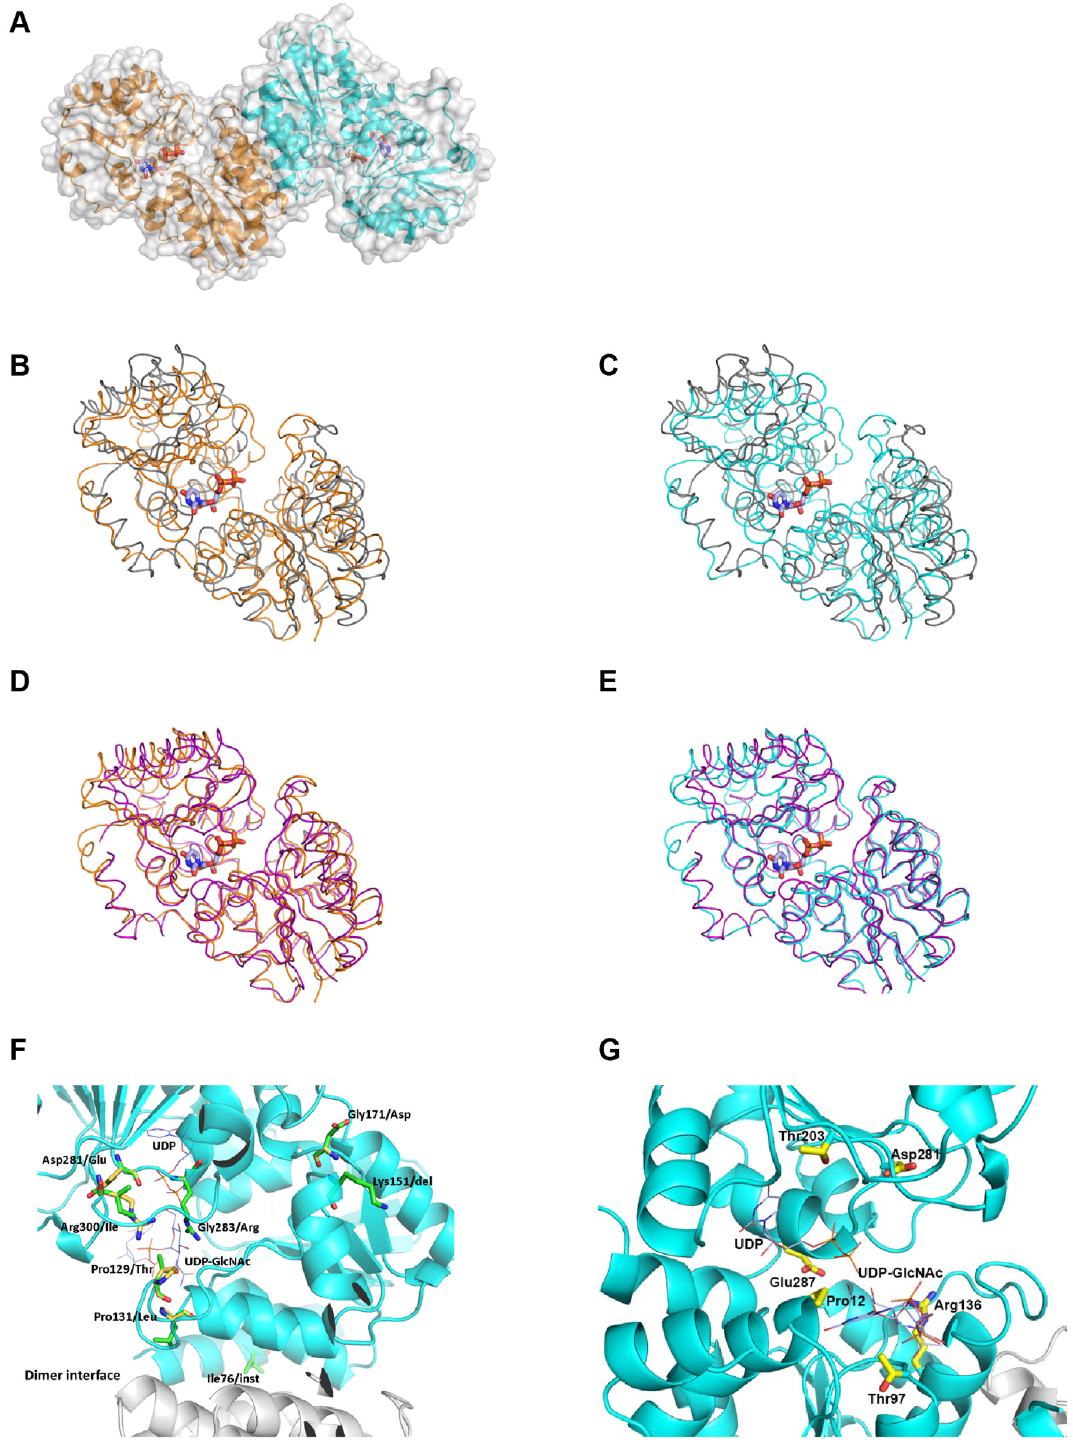
Fig 6. Mapping of MnaA LOF mutations into the MnaA crystal structure reveal key residues for substrate binding site stability and charge. (A) Overall MRSA COL MnaA crystal structure. The molecular surface is shown in grey. The protein is represented as a cartoon. In all figures one monomer is consistently colored in orange and the other in cyan, and the bound UDP molecules are shown as sticks, methyl groups colored in light blue. Nitrogen, oxygen and phosphor atoms are in blue, red or orange, respectively. (B,C,D,E) Comparison with the M . jannaschii structure in “ opened ” form (PDB 3NEQ) or “ closed ” form (PDB 3NES). Both structures are represented as ribbons, one monomer at a time, and UDP as sticks. (B) and (C) compares the opened